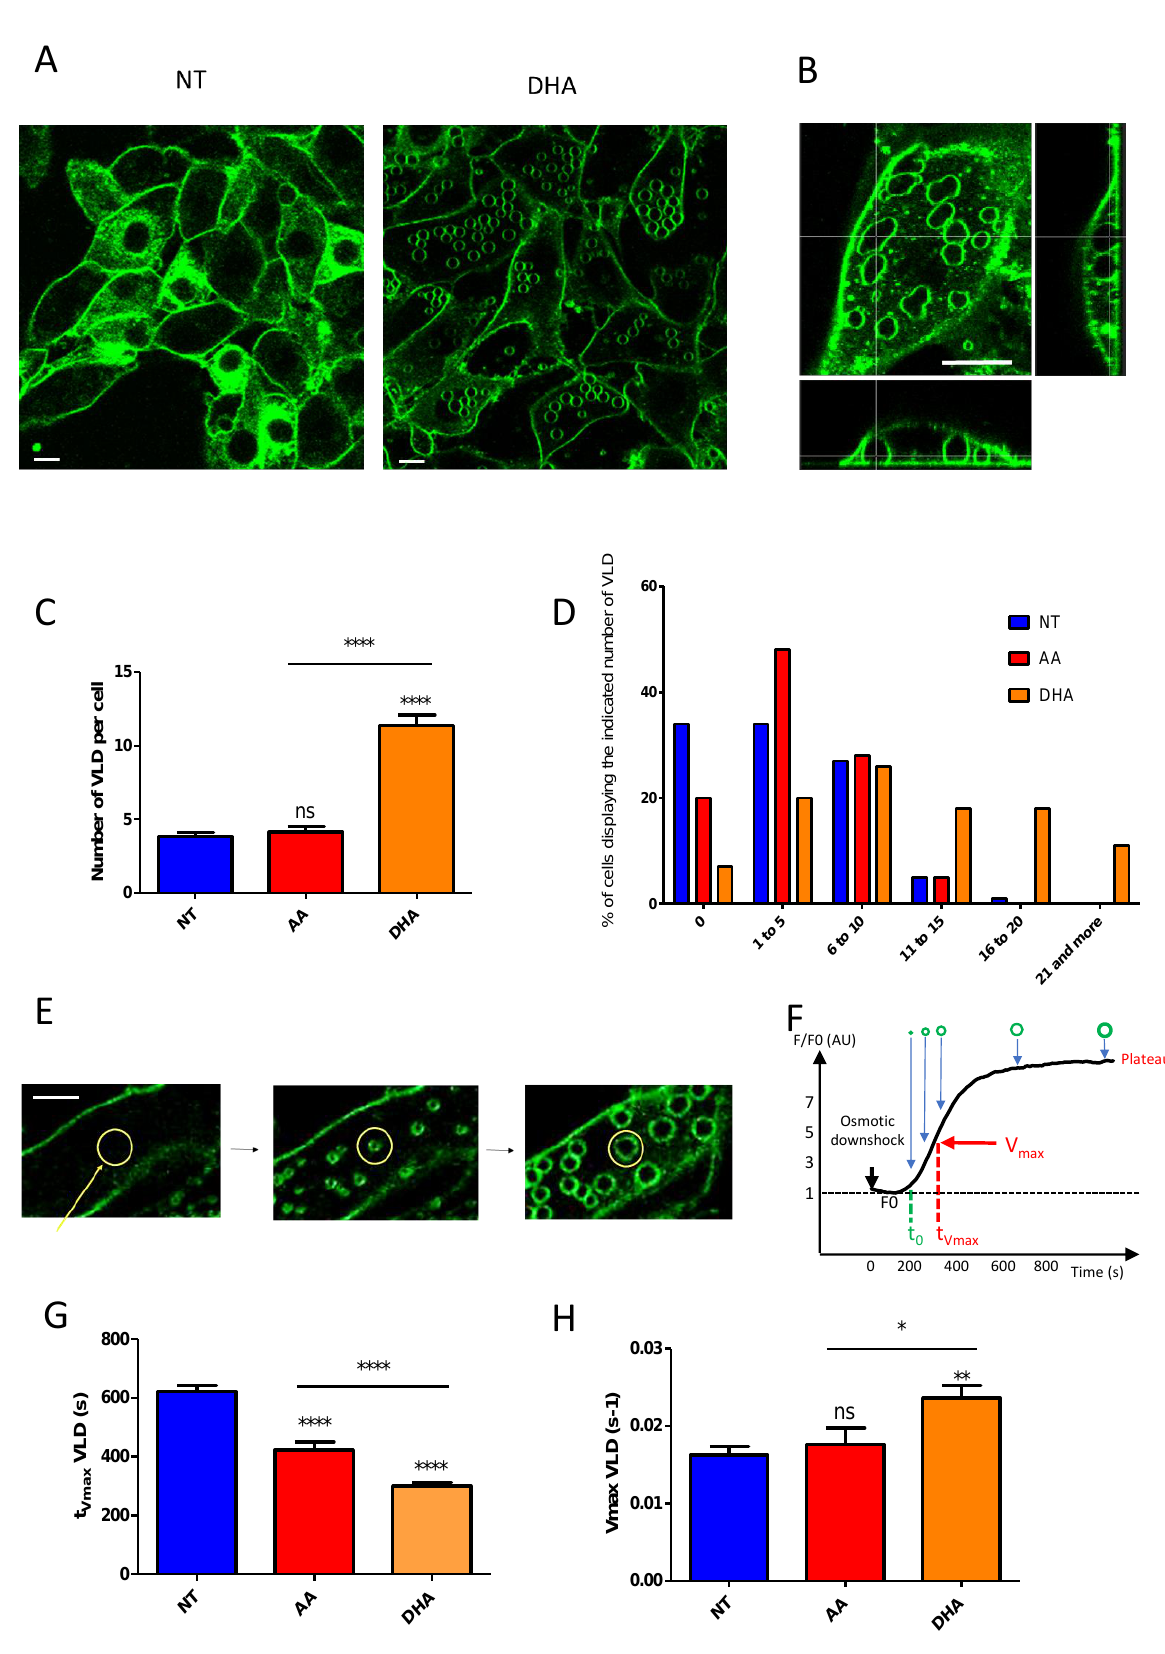
Figure 5. C2C12 respond differently to osmotic downshock depending on the nature of the fatty acid composition of their membrane phospholipids. ( A ) Representative fluorescence images (515 nm) of FM1-43-labeled myoblasts cultivated either in DHA-supplemented or not-supplemented (NT) media and submitted to osmotic shock. Scale bar: 10 µm. ( B ) 3D view of a cell exhibiting vacuole-like dilations (VLDs). Scale bar: 10 µm ( C ) Number of VLDs per cell in AA, DHA and not-